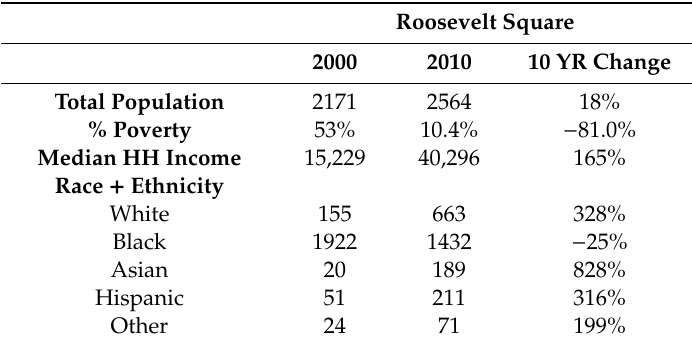
Table 2. Neighborhood change at Roosevelt Square. Roosevelt